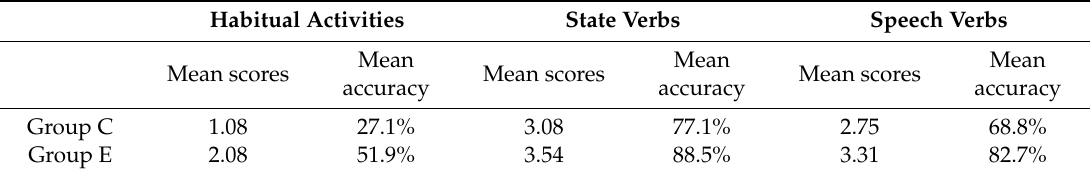
Table 5. Scores and accuracy rate in three - le forbidden situations in posttest.